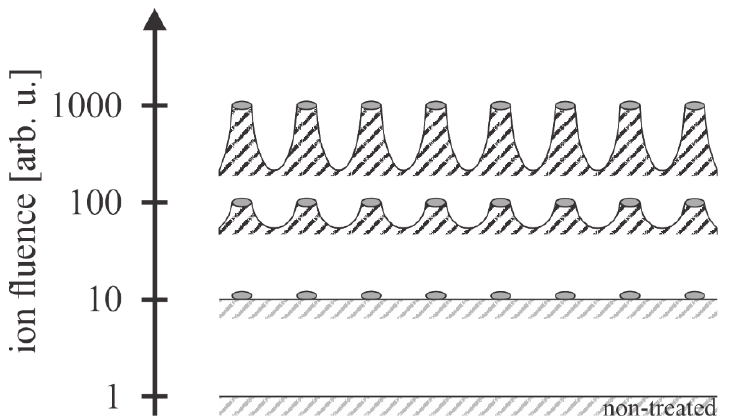
Figure 6. Illustration of the interaction of energetic oxygen ions with polyethylene terephthalate (not to scale). The aspect ratio between the height and the lateral dimension of the hillocks at large ion fluences may be well above 1.